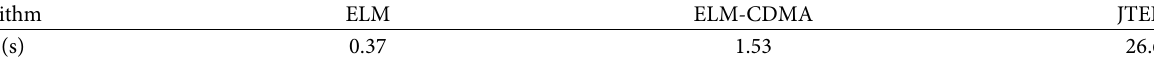
Table 6: Time consumption of ELM, ELM-CDMA, and JTELM on MNIST vs. USPS.